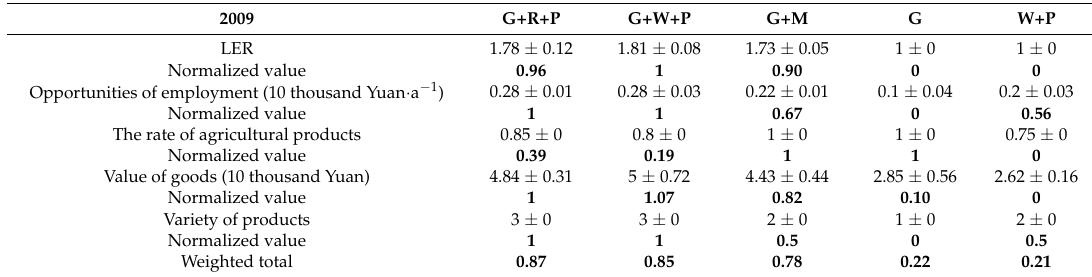
Table 6. Social indicators in three mixed Ginkgo systems, pure Ginkgo (G), and a cropping system (W+P), in 2009.